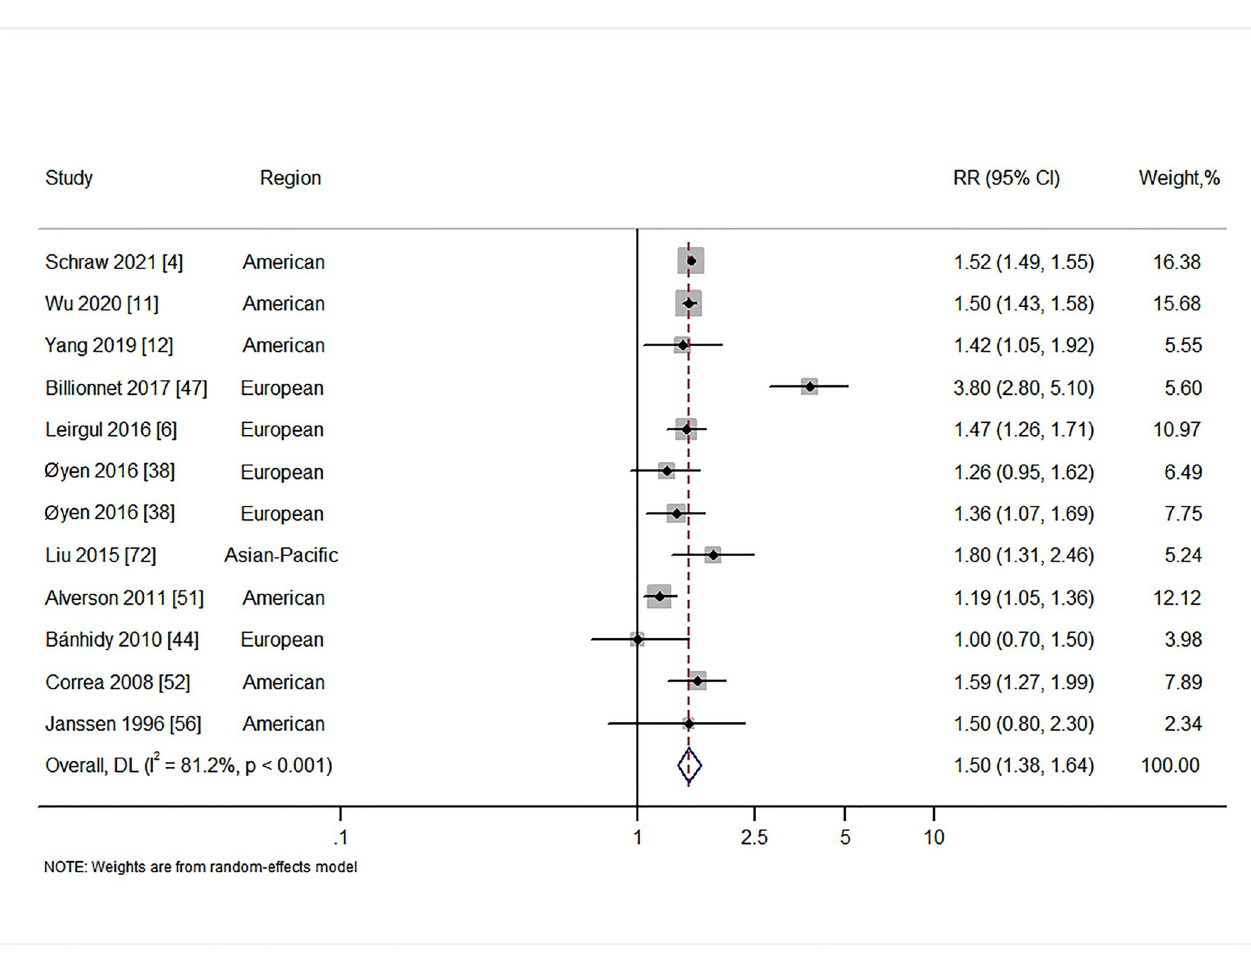
Fig 5. Forest plot of the RRs in population-based studies formaternal gestational diabetes and the risk of congenital heart defects (RR = 1.50, 95% CI 1.38 to 1.64, I 2 = 81.2%, P < 0.001). Analytical weights are from random effects meta-analysis. Grey boxes represent study estimates; their size is proportional to the respective analytical weight. Lines through the boxes represent the 95% CIs around the study estimates. The diamond represents the mean estimate and its 95% CI. The vertical red dashed line indicates the mean estimate. CI, confidence interval; DL, DerSimonian and Laird random effects model; RR, relative